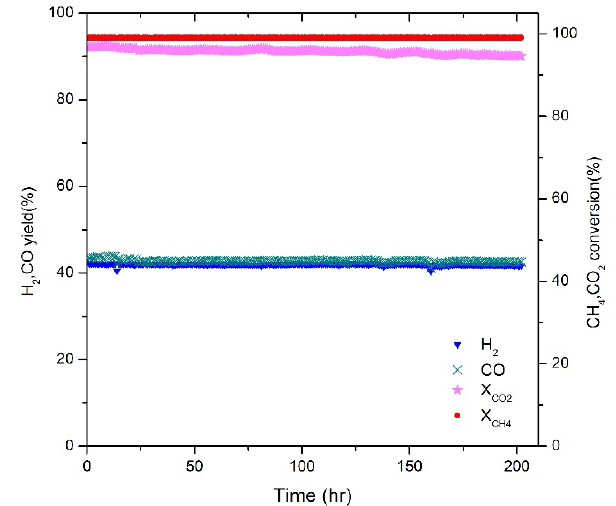
Figure 15. Durability of over 3 wt% Ni/Ce-MgO-ZrO 2 /Al 2 O 3 for 200-h biogas reforming reaction.